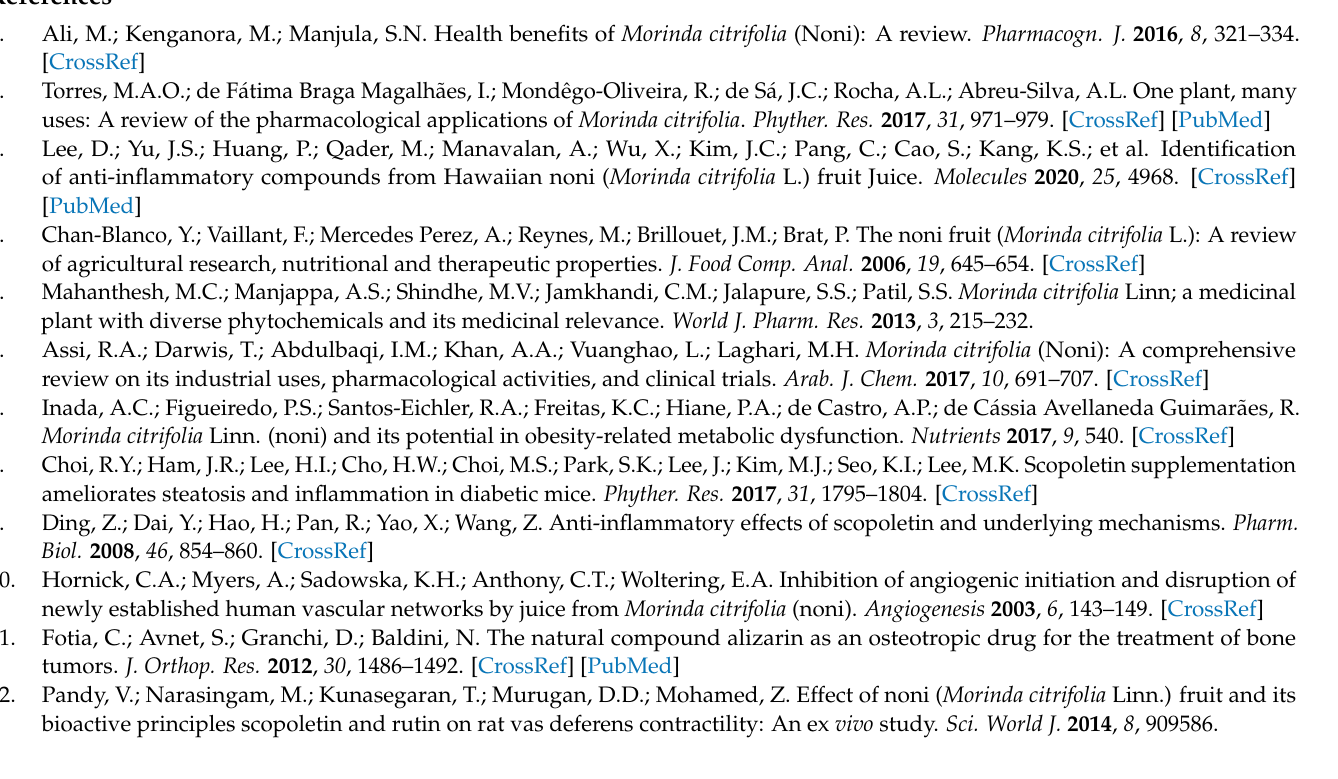
(b), Figure S3: HPLC chromatograms of subcritical water extract at 140 °C and 1 mL/min from noni fruits: scopoletin (RT: 9.87) and rutin (RT: 11.39) at 350 nm (a), and alizarin (RT: 24.54) at 250 nm (b), Table S1: The values of f , k 1 , and k 2 of bioactive compounds extracted by subcritical water fitted by the two-site kinetic model, Table S2: Determination coefficients and root mean square error values for the thermodynamic partitioning and two-site kinetic